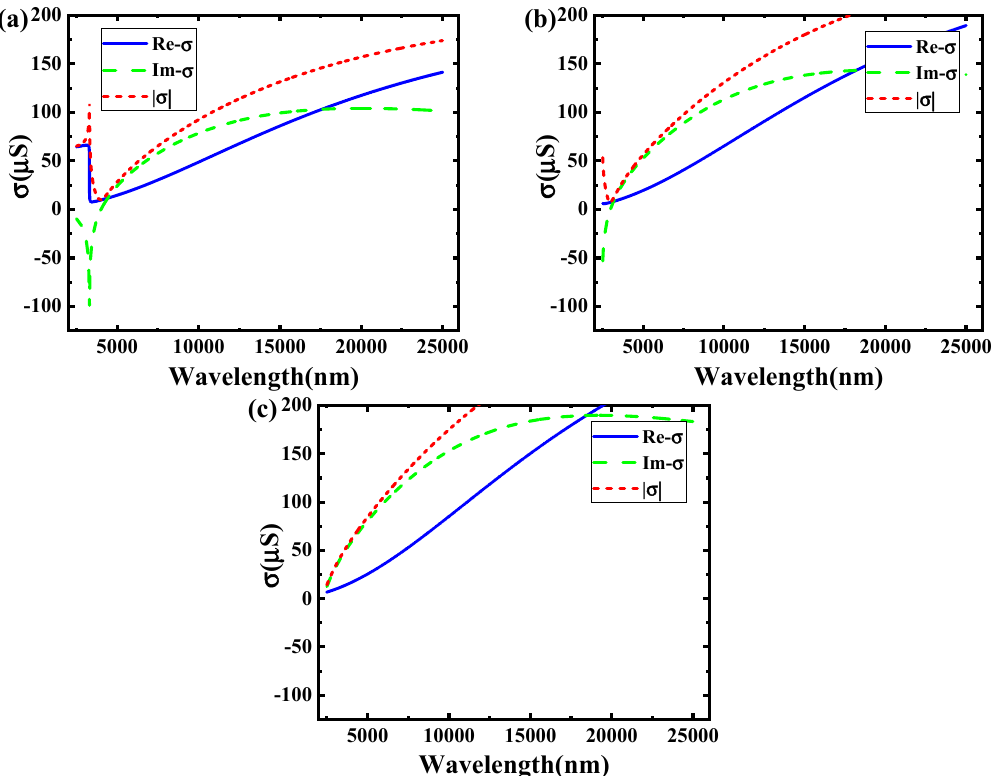
Figure 6. The image of conductivity as a function of incident wavelength in different substrate materials. ( a )SiO 2 ; ( b ) BN; ( c ) Si.